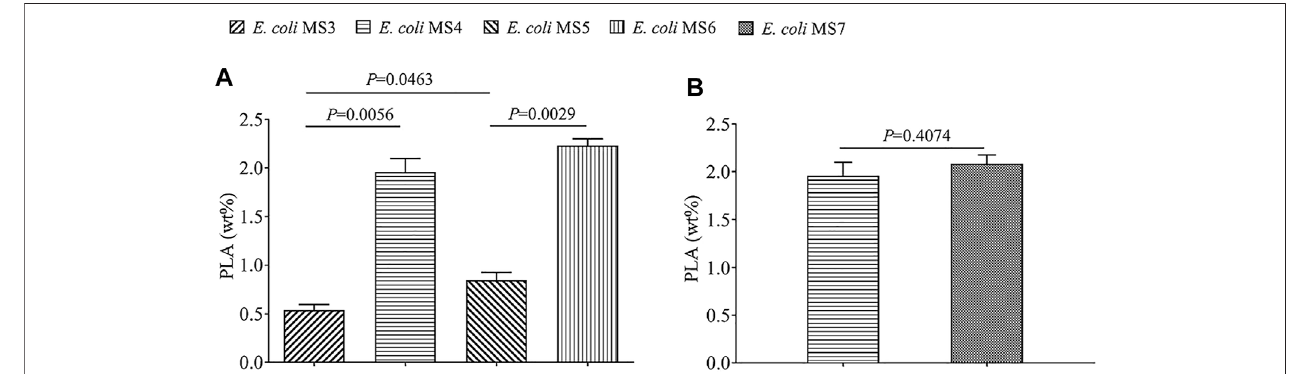
FIGURE 2 | Comparison of the PLA production by fi ve different engineered strains. The PLA production wasrecorded by wt% (weight of PLA/dry cell weight). The data shown are expressed asmeans of three repeated experiments, and the error bars present their standard deviation. Statistical difference( p value) between different groups is also present. (A) Strains which express the gene of PhaC1 Cs (class I PHA synthase) and sulA (for morphological engineering) have higher PLA production. (B) Strain which expresses the fused enzyme of Pct Cp /LdhA has similar PLA production with the control strain.